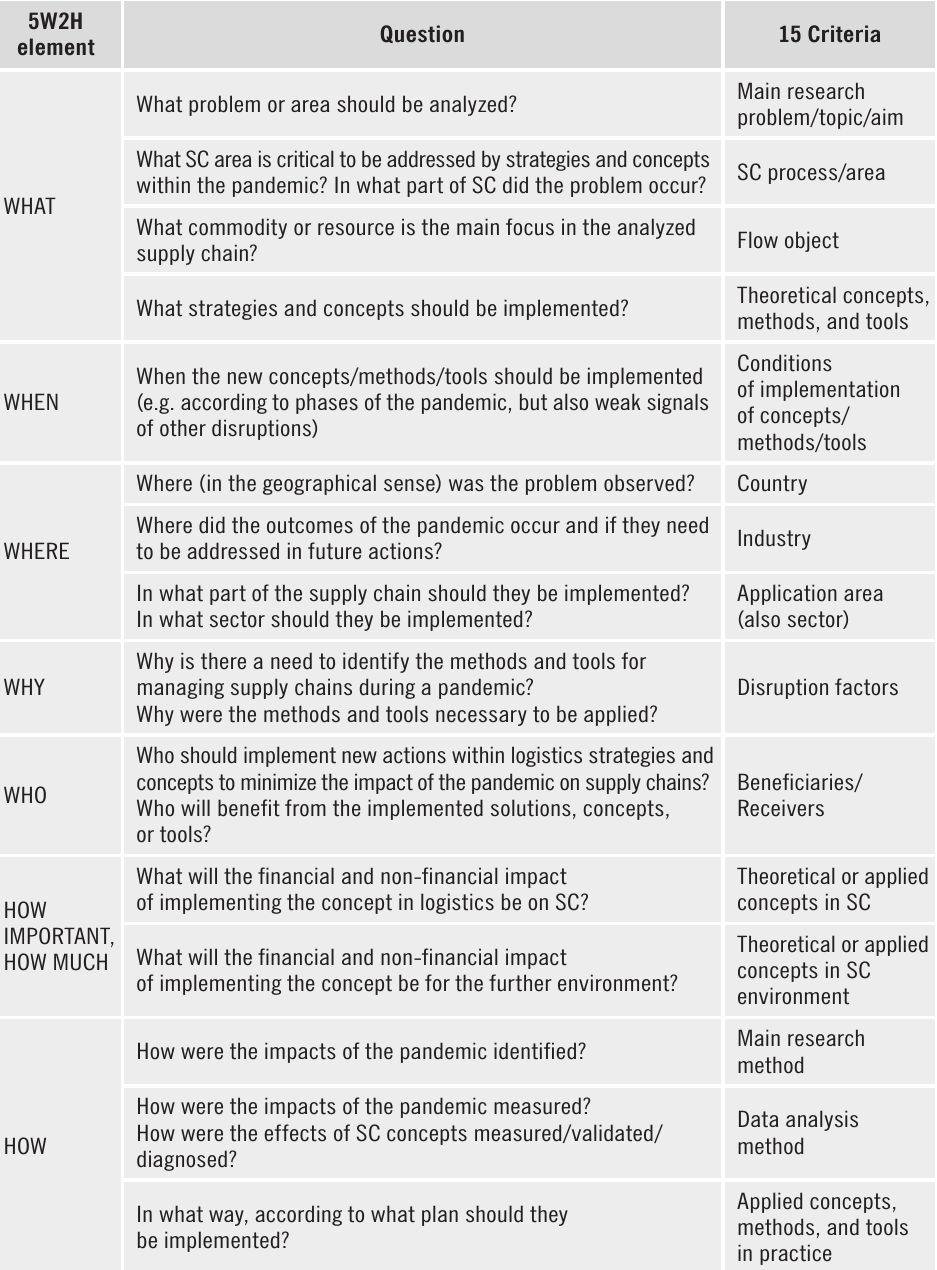
Table 1. The application of the 5W2H approach to identify 15 research criteria for SLR